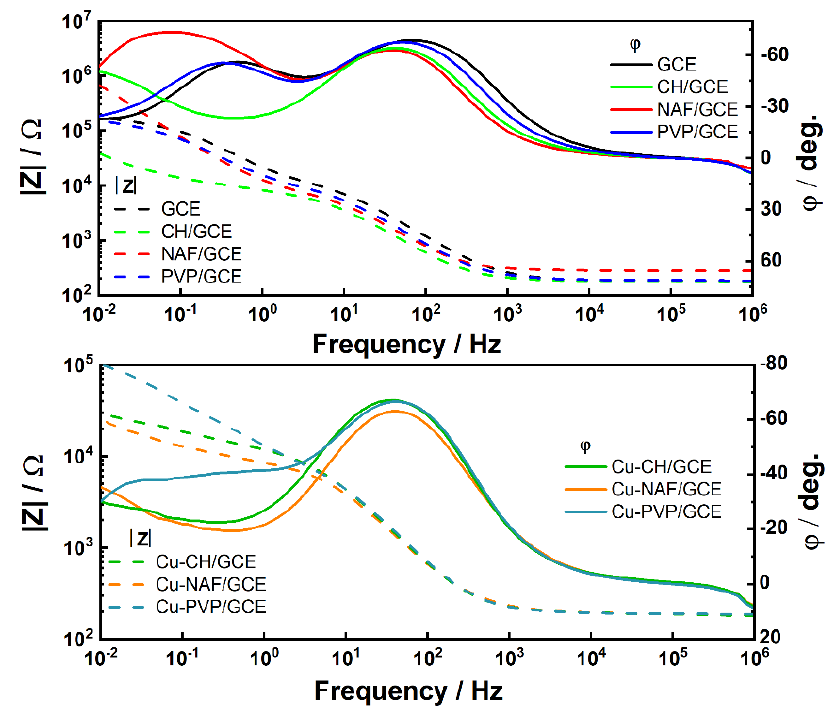
Figure 2. Impedance spectra in the Body configuration for bare and modified GCEs in the 0.1 M KCl + 0.2 mM [Fe(CN) 6 ] 3 − /4 −